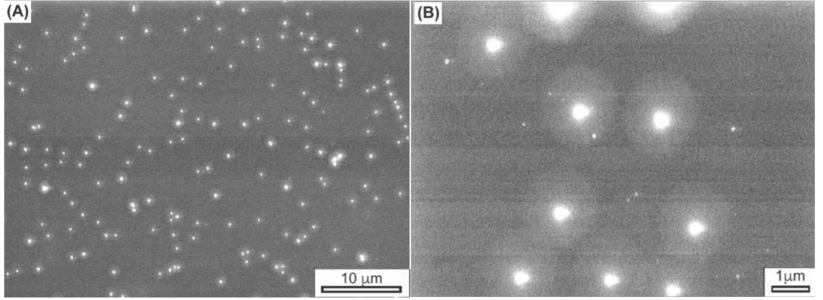
Figure 3. SEM images of ( A ) the hydrogel-coated nanoshells and ( B ) an enlarged-view of the same